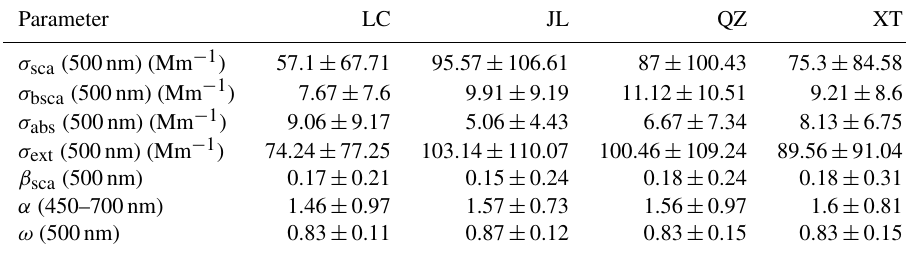
Table 4. Means and standard deviations of aerosol optical properties over LC, JL, QZ, and XT during the experiment.